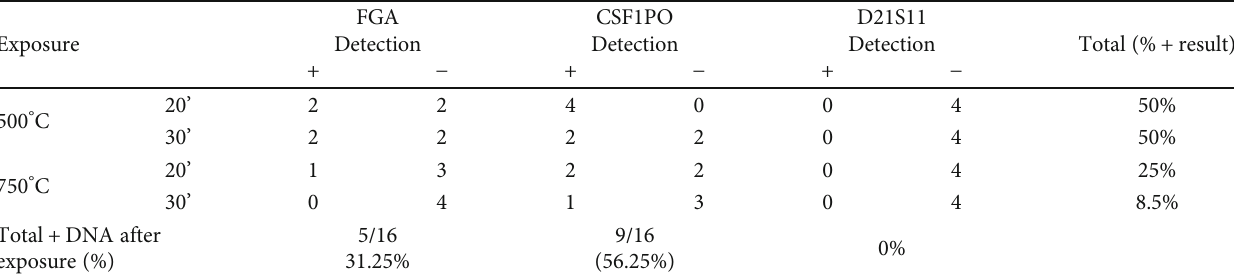
Table 3: Results of DNA detection on STR CODIS examining the e ff ect of high-temperature exposure on tooth sample DNA with various temperature treatment and length of treatment on FGA, CSF1PO, and D21S11 loci.